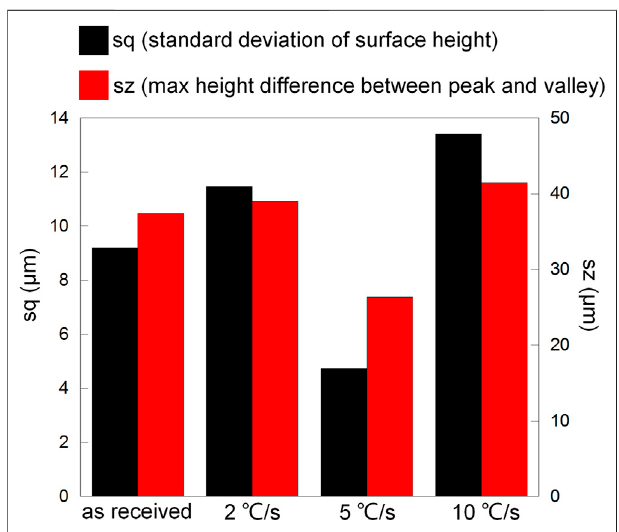
FIGURE 12 | Surface pro fi le data (sq and sz) regarding Figure 11